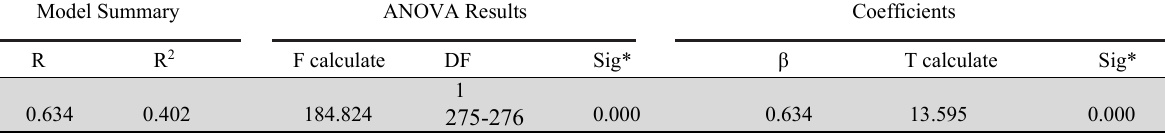
Results of simple regression analysis for the effect of PI-TD on IO Model